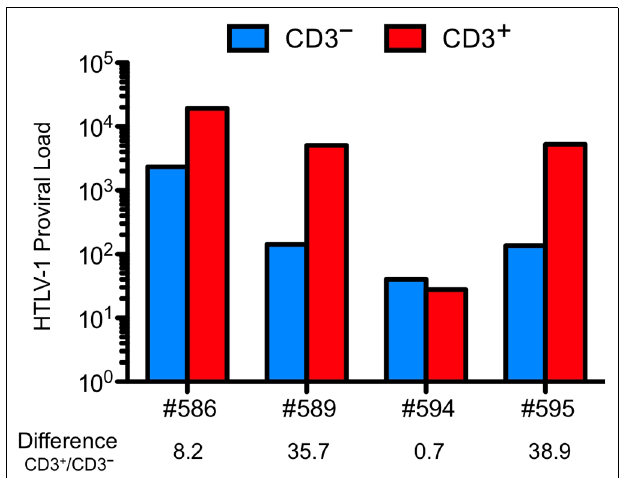
FIGURE 4 | HumanT cell leukemia virus type 1 (HTLV-1) provirus is detected in immature thymocytes and higher PVL is found in more mature thymocytes. The cells isolated from the thymus of four animals infected at the age of 4 weeks and sacrificed at 18 weeks (#594 and #595) or 31 weeks (# 586 and #589) were sorted on their expression of CD3. Proviral load (PVL) was measured on the DNA extracted form the two sorted populations. Except for the mouse #594, the PVL in the CD3 + populations is higher. PVL is defined as the number of copies of HTLV-1 in 100,000 human cells. Table 2 |The humanT cell development is altered in HTLV-1 infected HIS Rag2 − / − γ c − / − mice.